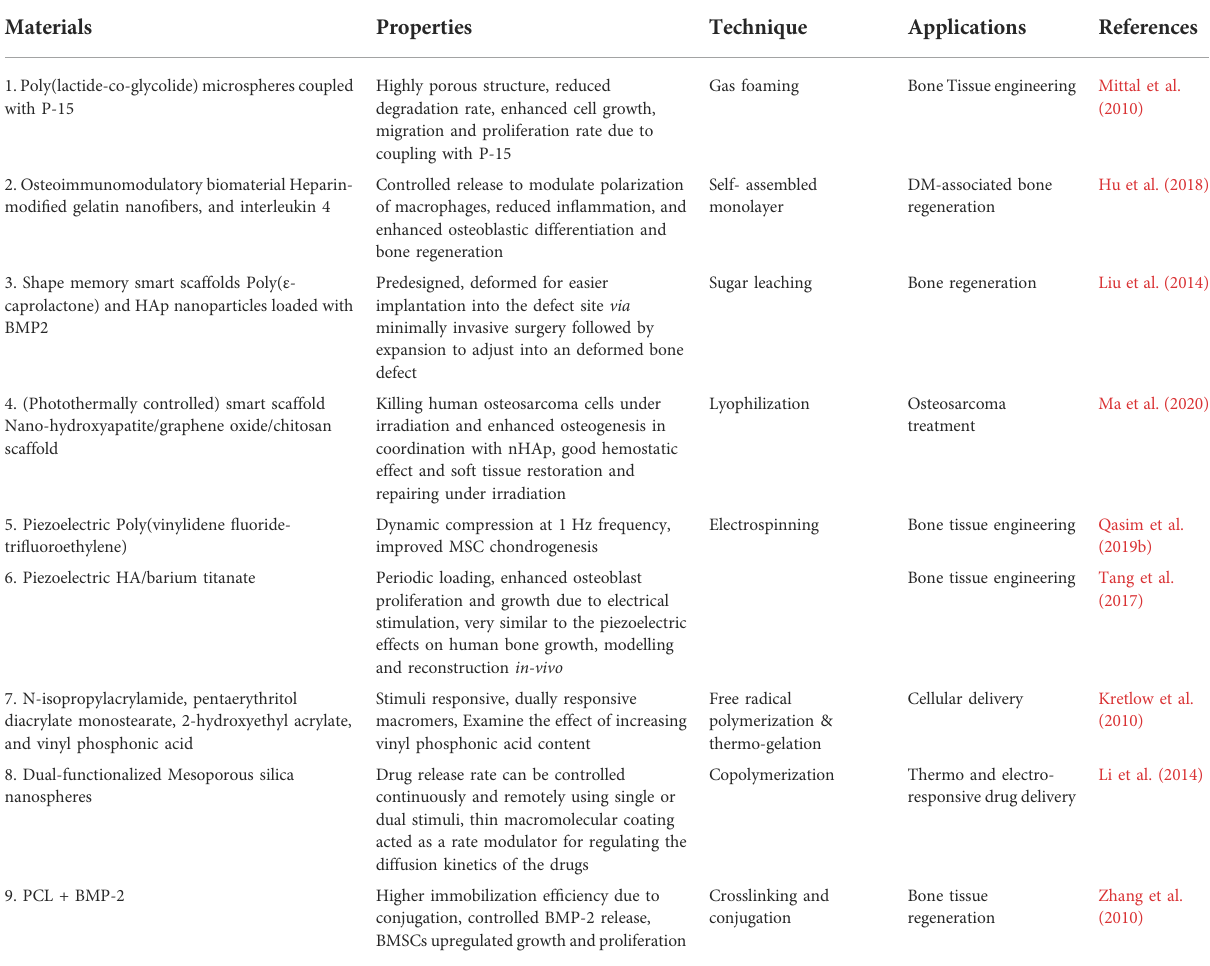
TABLE 3 Smart materials and their applications in